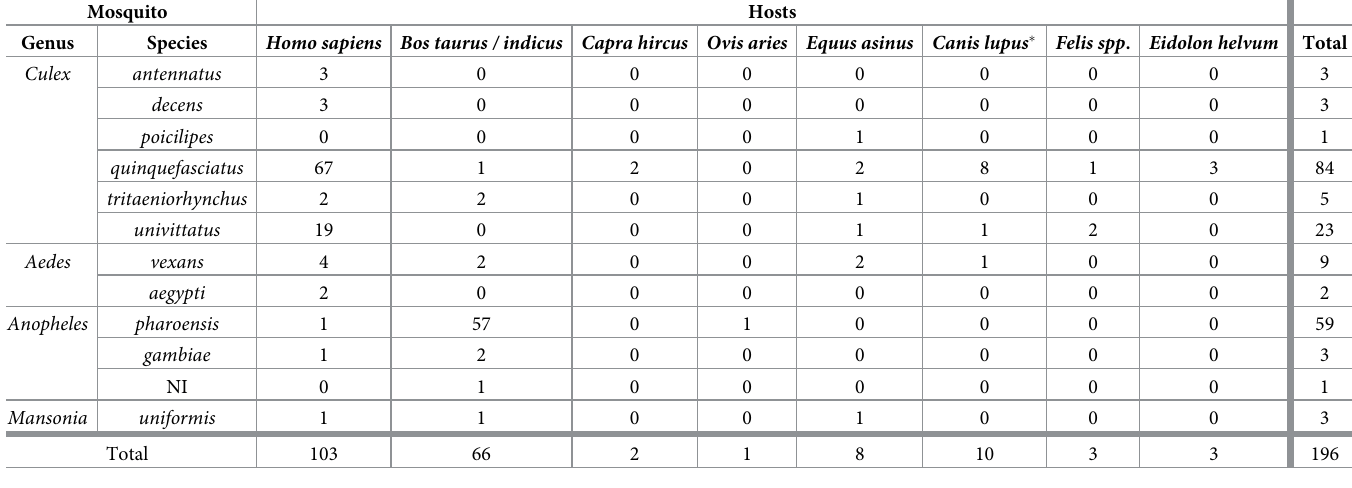
Table 6. Blood meal sources (hosts) of blood-fed mosquitoes. Mosquito